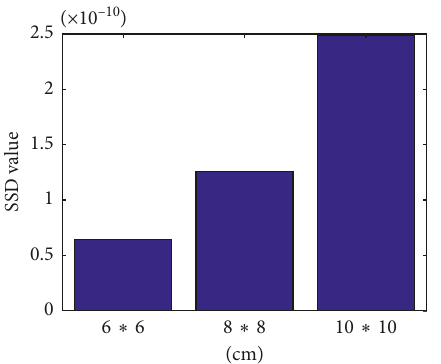
Figure 6: SSD results at different levels of simulated